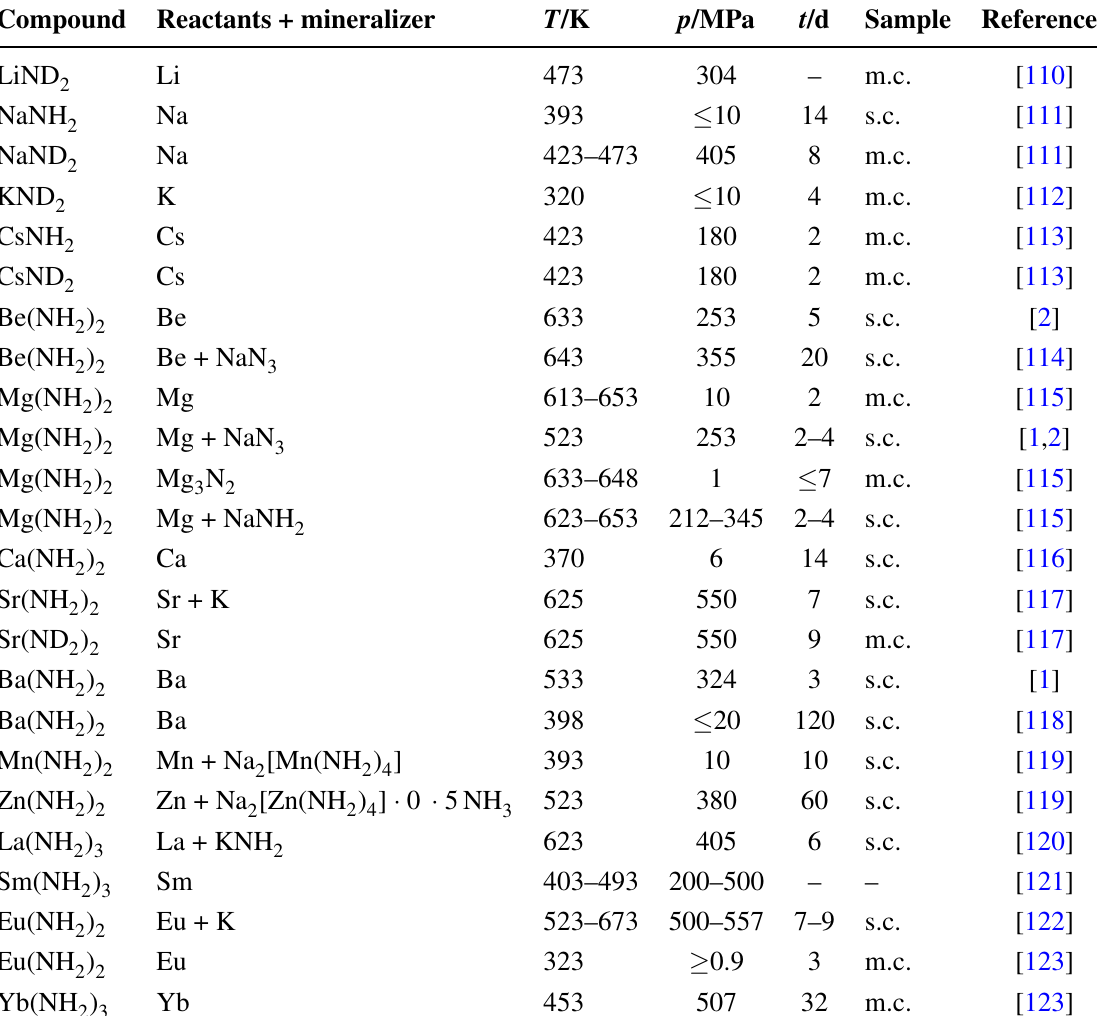
Table 4. Conditions for the ammonothermal synthesis of binary amides and deuteroamides (synthesized using ND 3